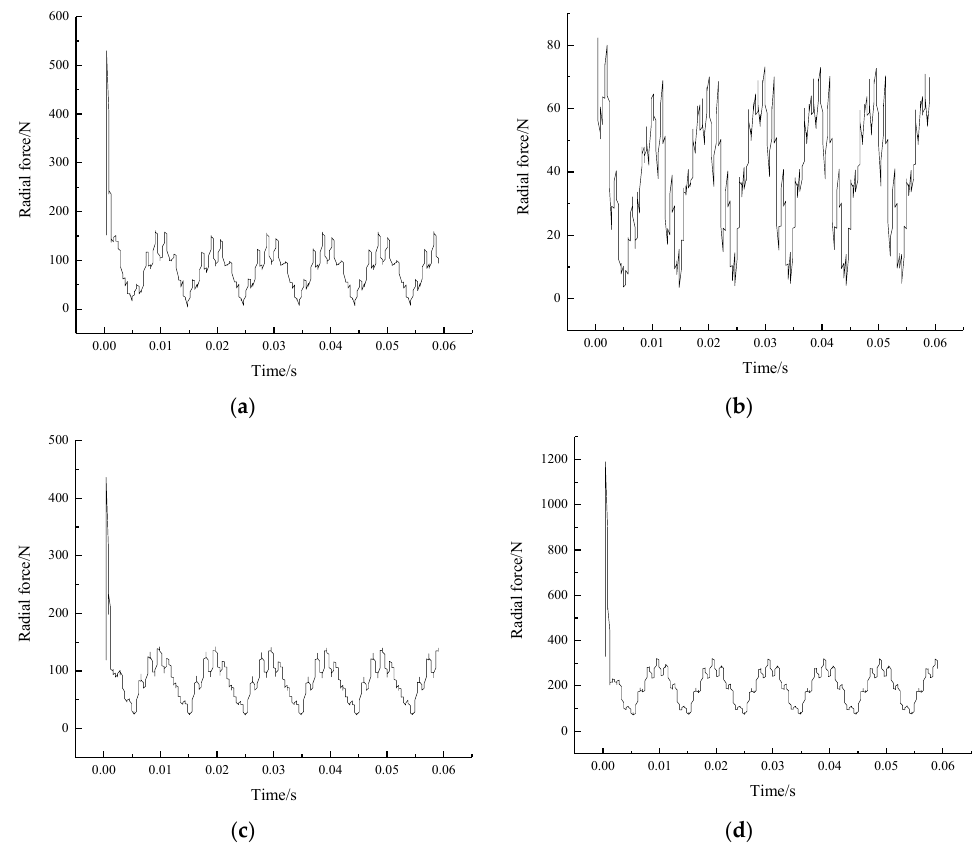
Figure 11. Transient radial force curve of impeller under different working conditions; ( a ) 0.8 Q ; ( b ) Q; ( c ) 1.2 Q ; ( d ) 1.5 Q